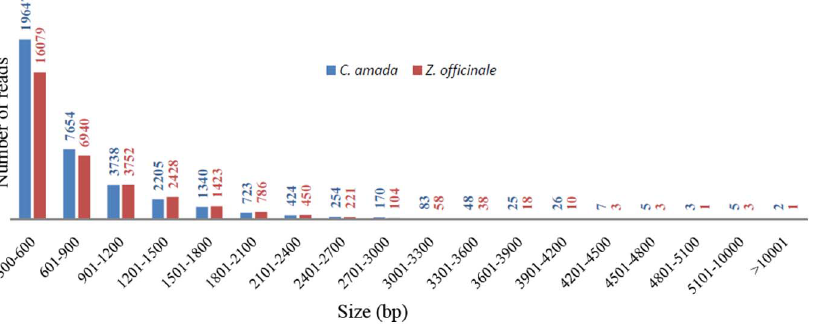
Figure 1. Sequence length distribution of assembled contigs in the transcriptomes of C. amada and Z. officinale. Histogram presentation of sequence-length distribution for significant matches that was found. The x-axis indicates sequence sizes from 300 nt to . 10001 nt. The y-axis indicates the number of contigs for every given size range. doi:10.1371/journal.pone.0099731.g001 PLOS ONE |